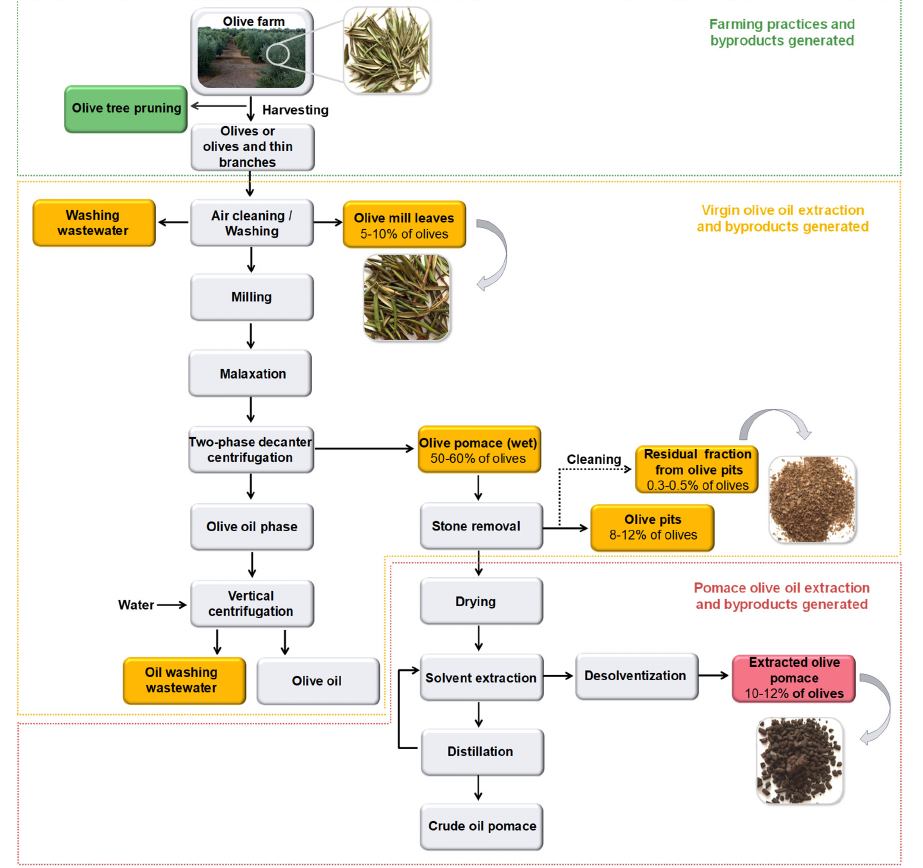
Figure 1. Simplified schemes of the extraction of virgin olive oil and pomace olive oil and the byproducts (squares in green, yellow, and pink) generated during the production steps.